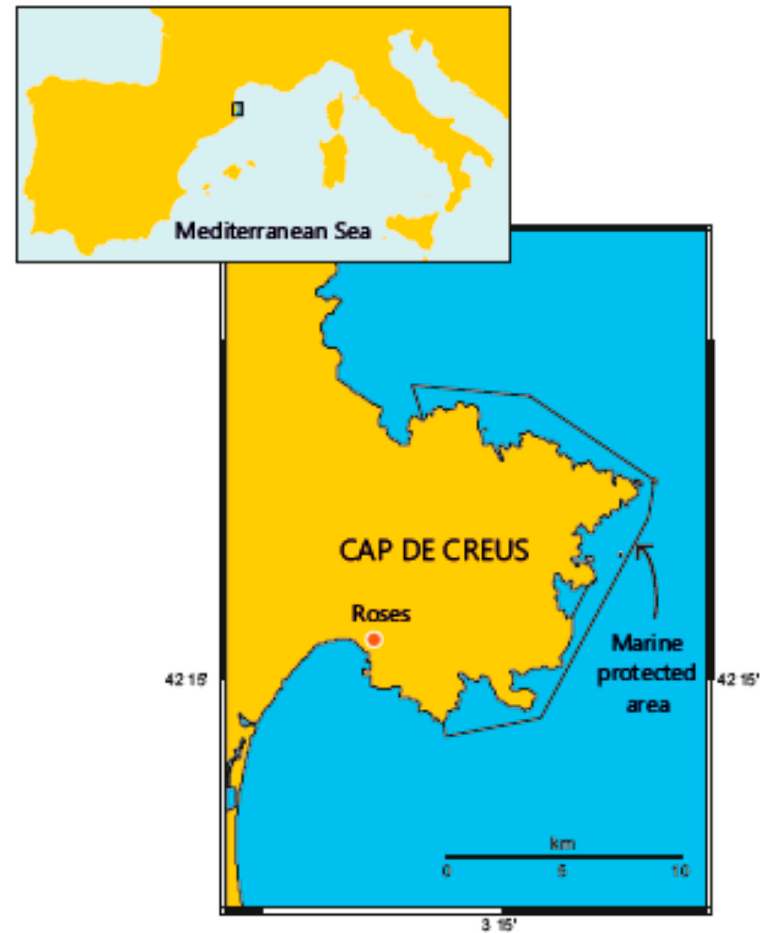
Figure 1. Map of the area where the Oceans and Human Health (OHH) Chair is implemented in the northwestern Mediterranean, showing the City of Roses and the marine protected area of Cap de